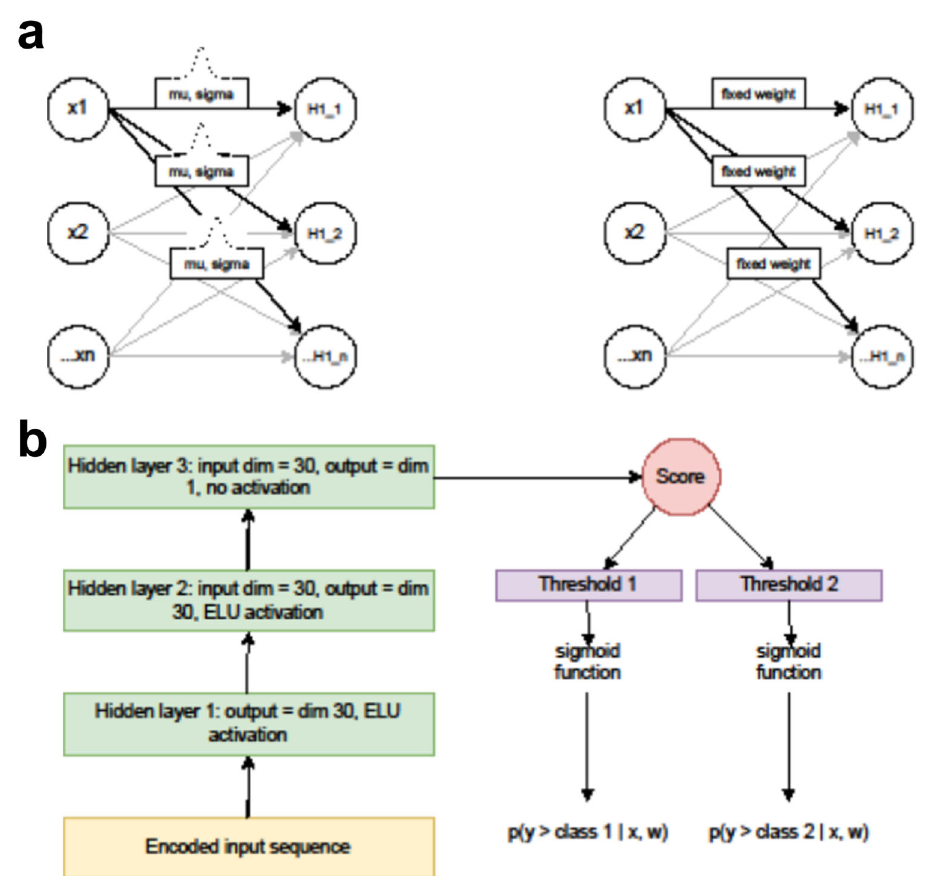
Fig.9|ThevariationalBayesianneuralnetworkarchitecture.a Acomparisonof a variational Bayesian neural network with a fully connected architecture. Both networks map a vector of input values x1, x2, … xn to a hidden layer vector H1_1, H1_2, … H1_n by a matrix multiplication followed by a nonlinear activation. In the fullyconnected network, however,each element of the hiddenlayer weight matrix is a learnedvalue and oncethe networkistrained it isa fi xedvalue.In the Bayesian